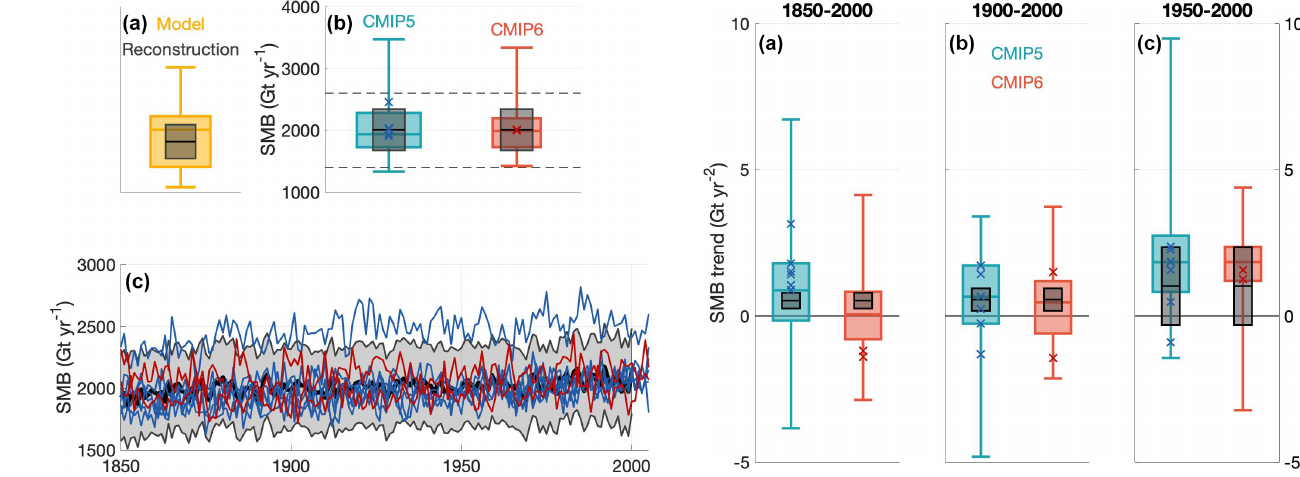
Figure 3. (a) An example of a box plot for model data (yellow) and reconstructed data (black and grey). The yellow shaded box shows the models’ interquartile range while the whiskers extend to capture the entire distribution of modeled data. The line going through the box plot shows the median model value. The grey shaded box shows the reconstructed uncertainty around the reconstructed value shown as a black line. (b) A box plot of spatially integrated, temporally av- eraged (1850–2000) AIS SMB for CMIP5 (aqua) and CMIP6 (red). The dark blue x’s associated with the CMIP5 box and the red x’s as- sociated with the CMIP6 box represent the eight best scoring mod- els: GISS E2 H CC, GISS E2 R CC, GISS E2 R, MPI ESM LR, MPI ESM MR, and MPI ESM P from CMIP5 and CESM2 FV2 and MPI ESM2 LR from CMIP6. The black dashed lines indicate the lower and upper bounds of the time series plot in the bottom of Fig. 3. (c) A time series of spatially integrated SMB for the reconstruction (black) and its uncertainty (shaded grey) with the best eight scoring models: GISS E2 H CC, GISS E2 R CC, GISS E2 R, MPI ESM LR, MPI ESM MR, and MPI ESM P from CMIP5 (dark blue) and CESM2 FV2 and MPI ESM2 LR from CMIP6 (red).